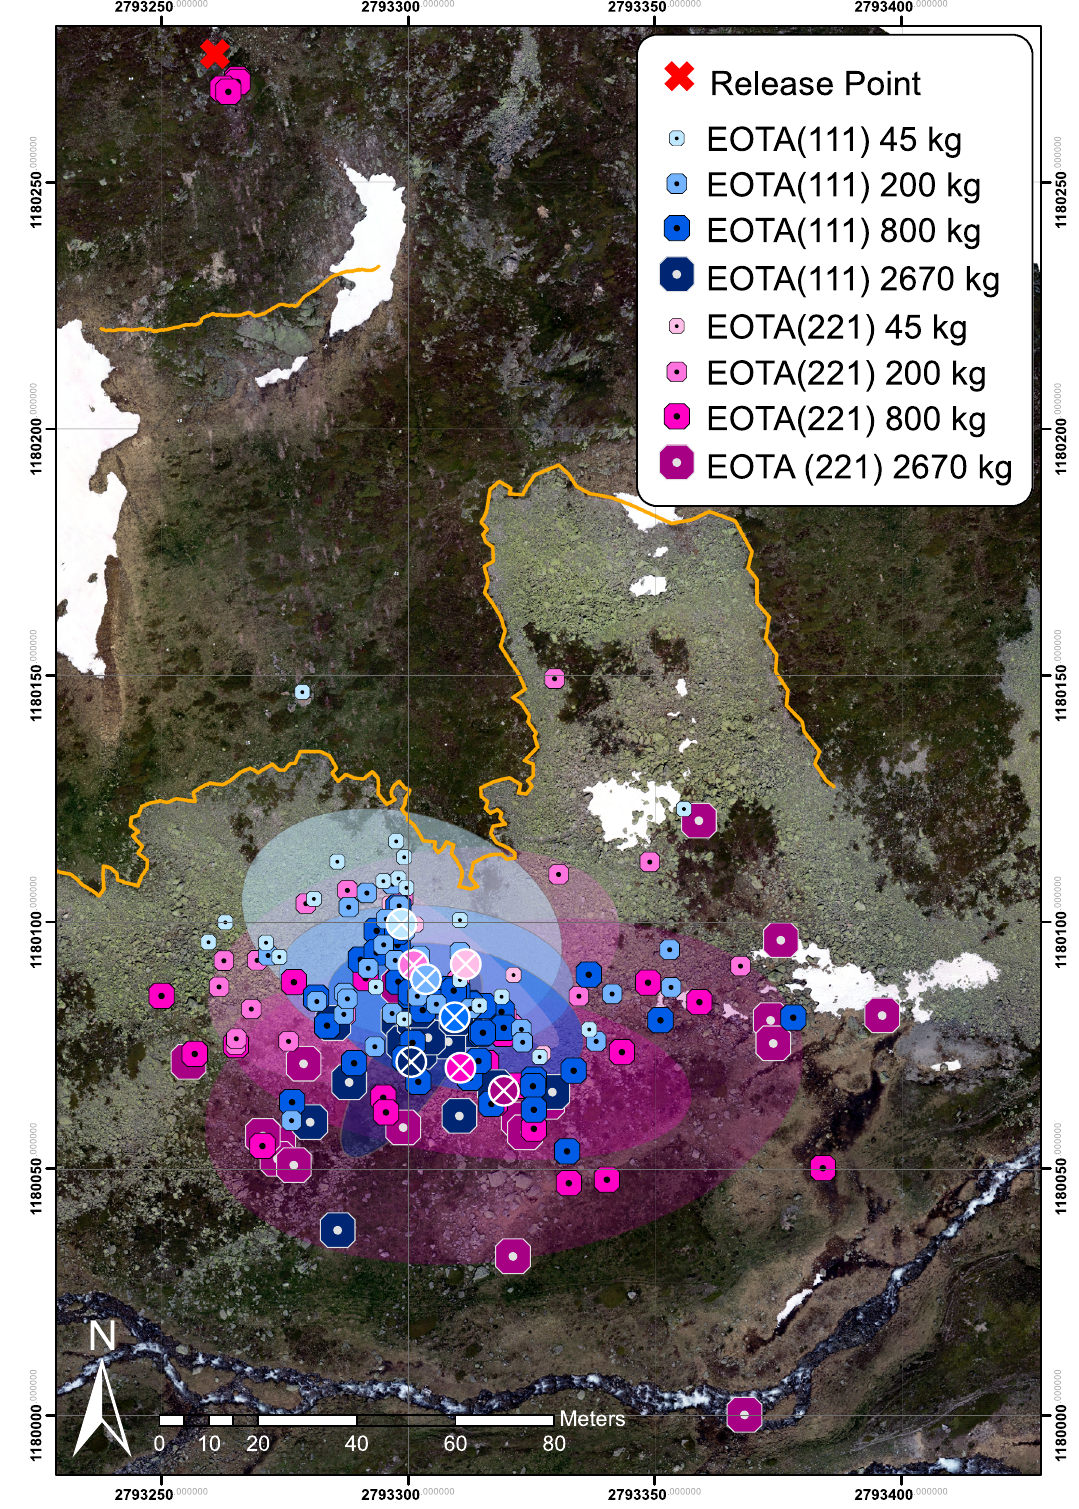
Fig. 2 Complete set of 183 deposition points of the Chant Sura Experimental Campaign. Blue markers represent equant EOTA 111 rocks varying from 45 kg (light blue) to 2670 kg (dark blue). Wheel-shaped EOTA 221 deposition points are shown in magenta with masses from 45 kg (light magenta) to 2670 kg (dark magenta). The respective centres of mass for each rock category is indicated with a crossed circle in the same colour together with its fi rst standard deviation